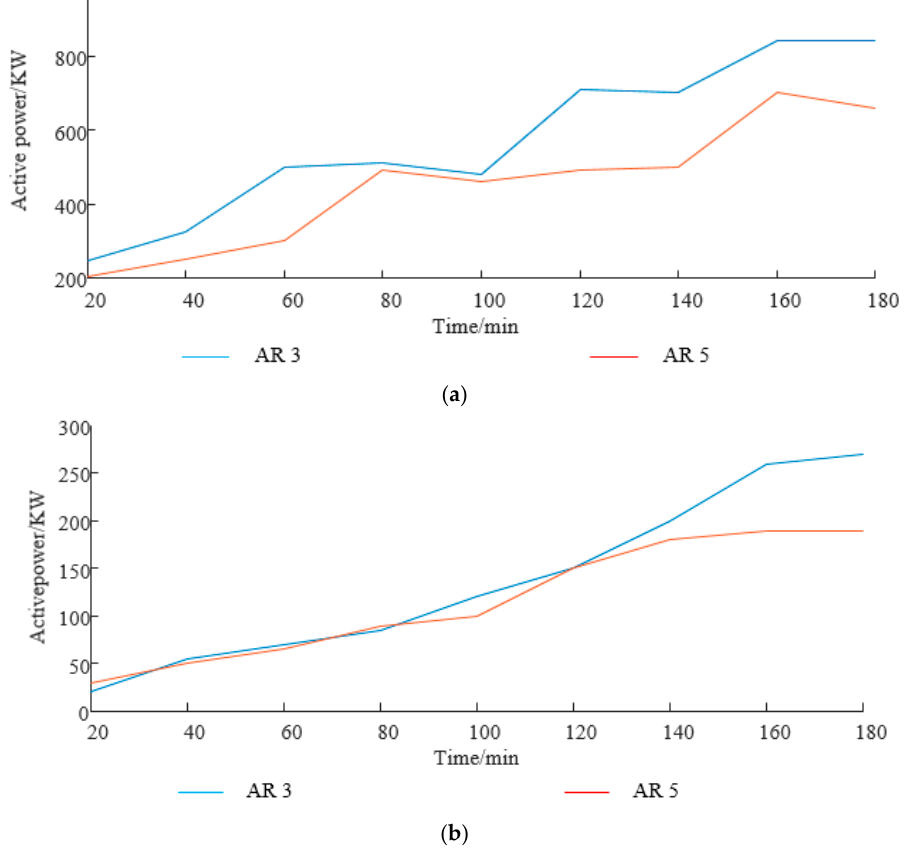
Figure 6. Amount of active change in autonomous regions (ARs) 3 and 5 : ( a ) Total active power change in the region and ( b ) total wind power and photovoltaic (PV) active power output change in the region. Table 2. Bus voltage fluctuations in ARs 3 and